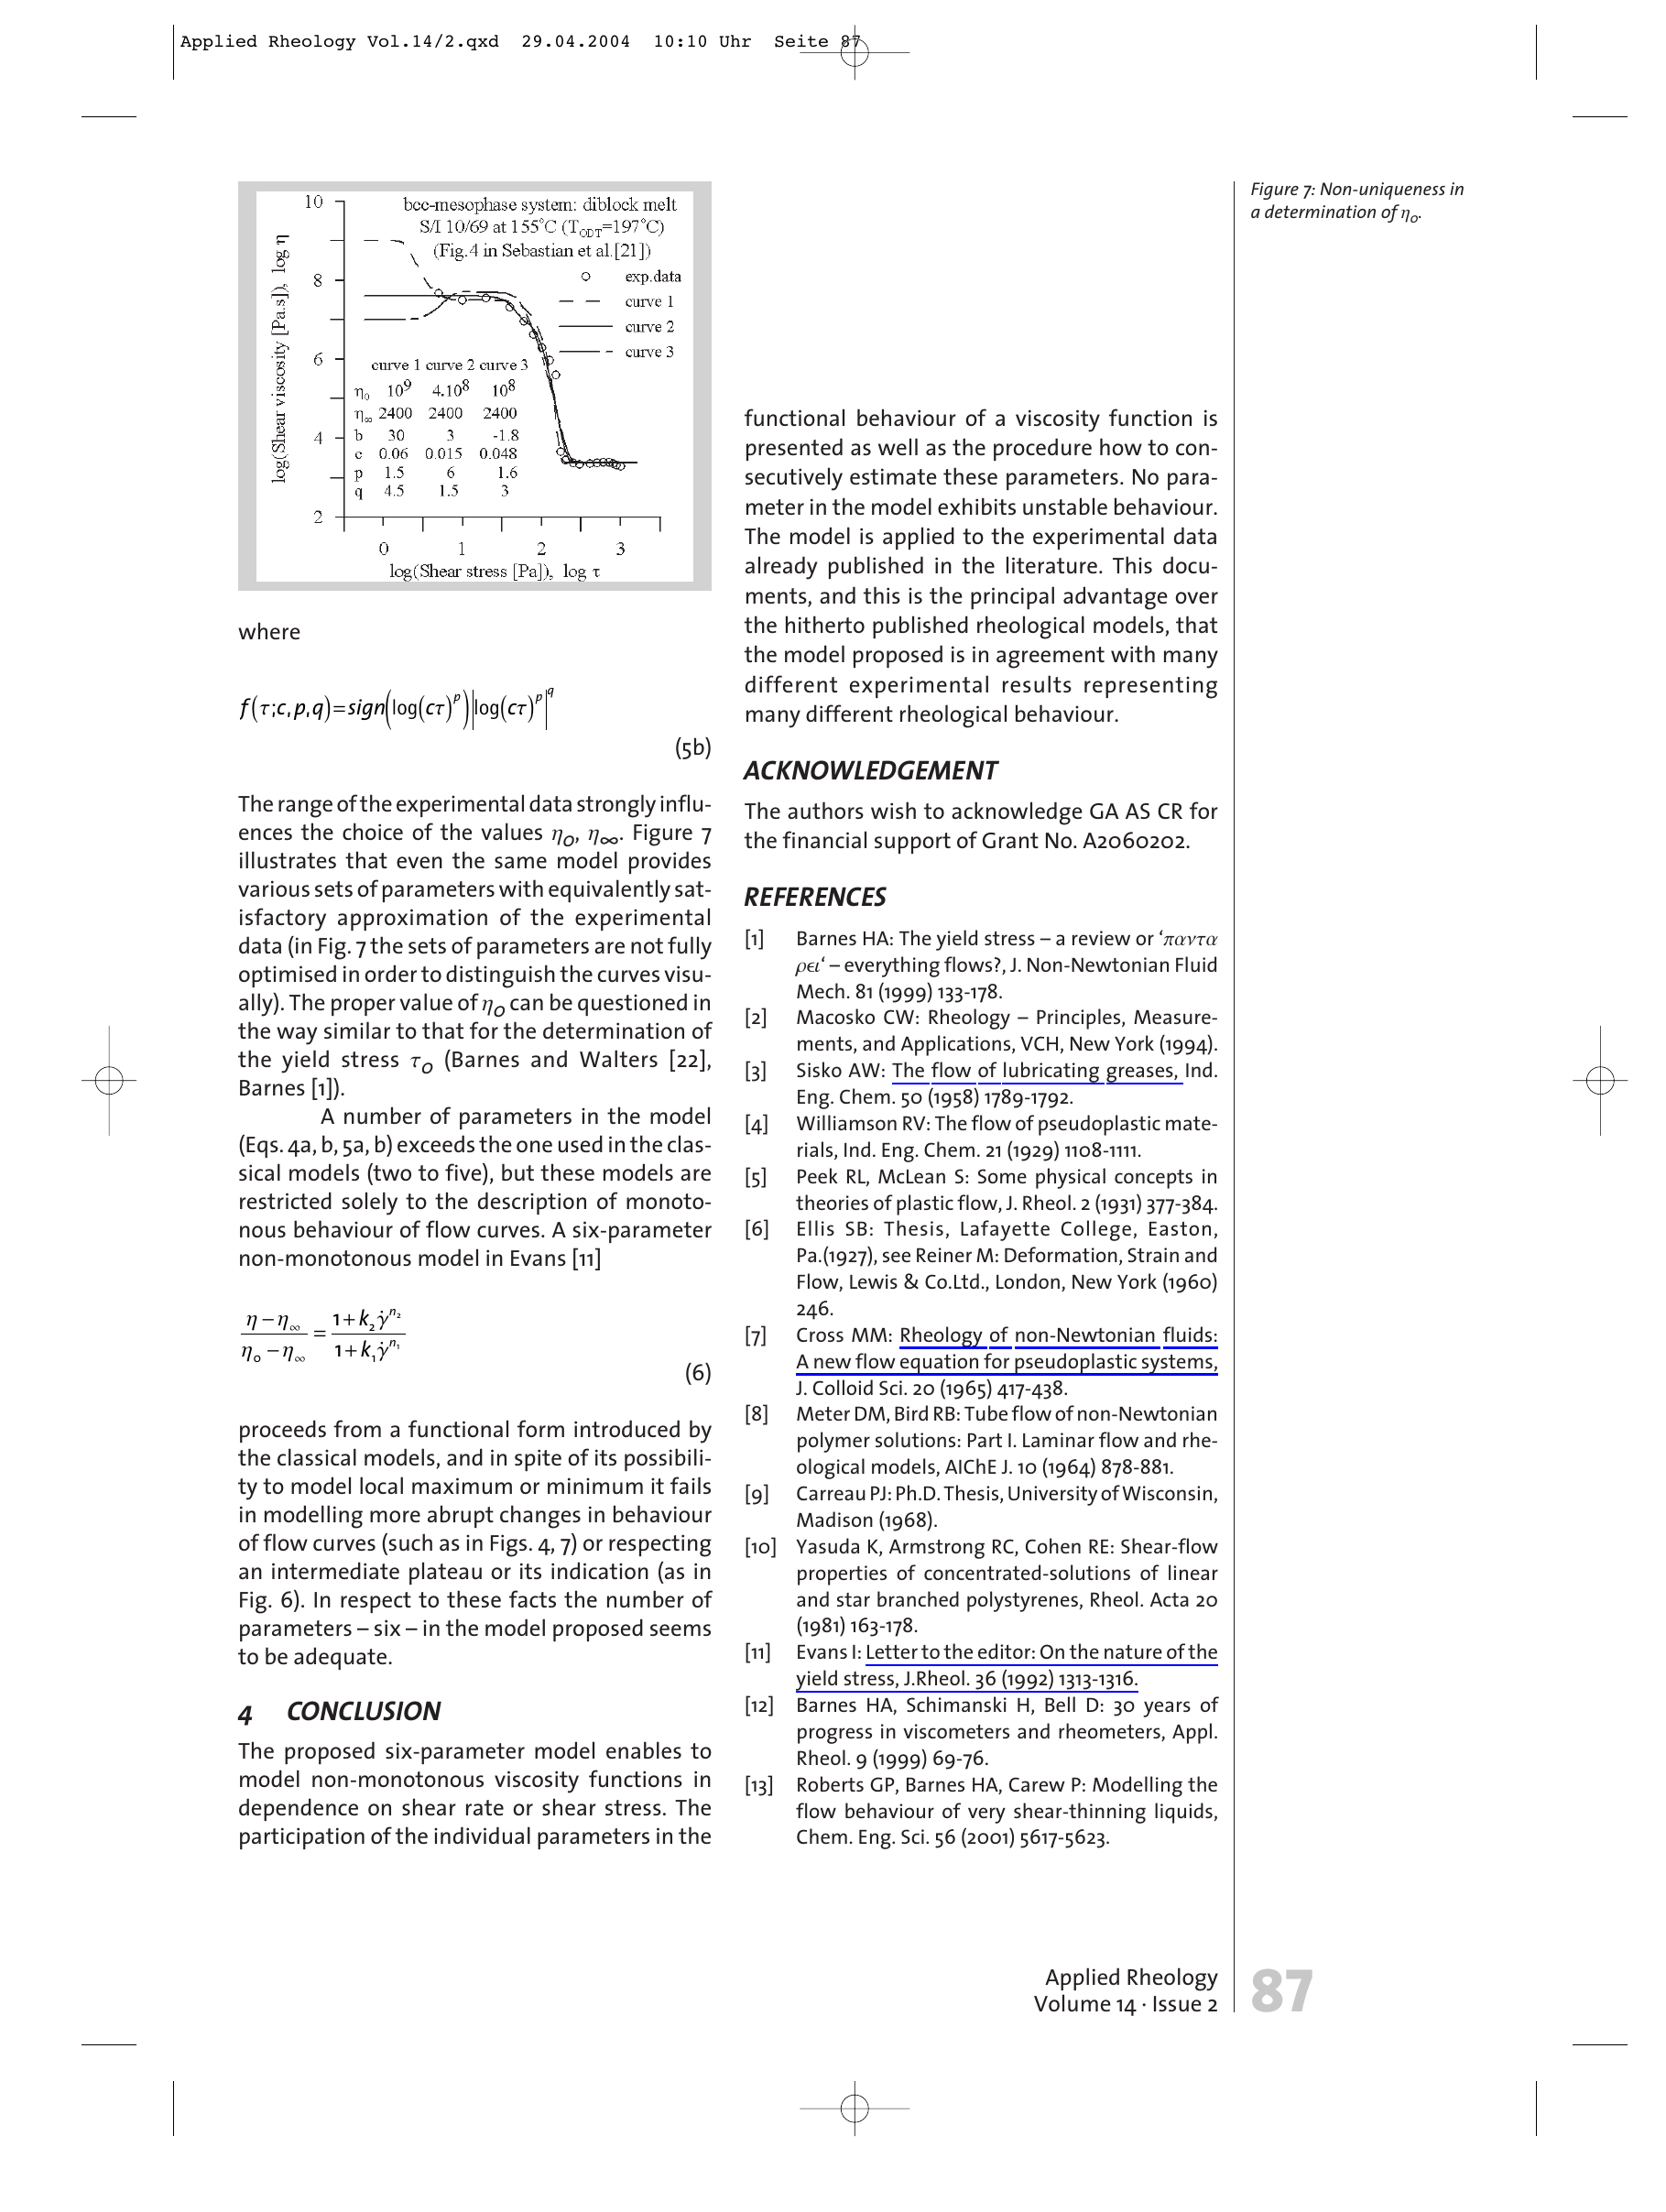
Figure 7: Non-uniqueness in a determination of h 0